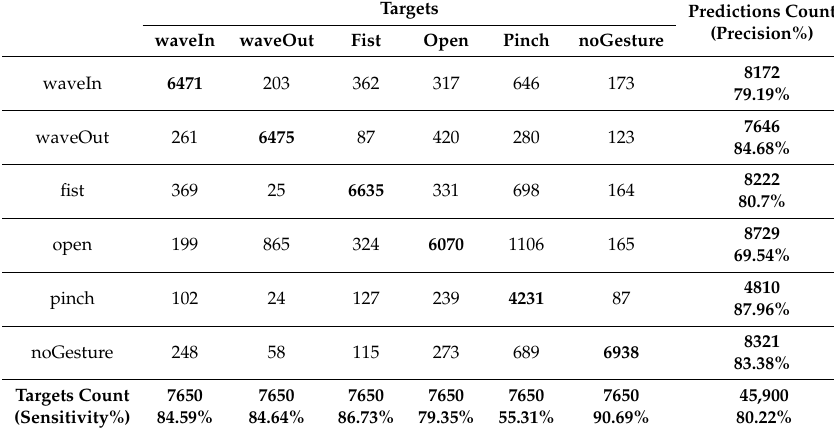
Table A14. Confusion matrix for experiment 4 . Synchronization gestures ( sync = 1 ) .